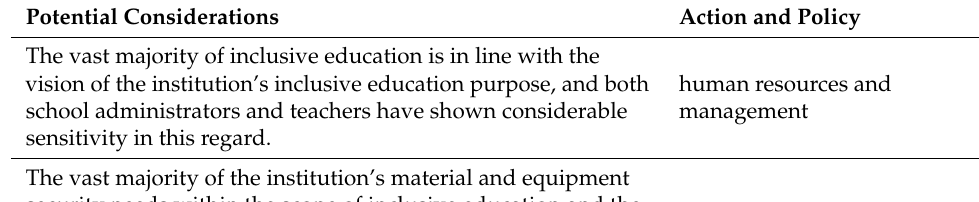
Table 5. Sustainable managerial implications in inclusive